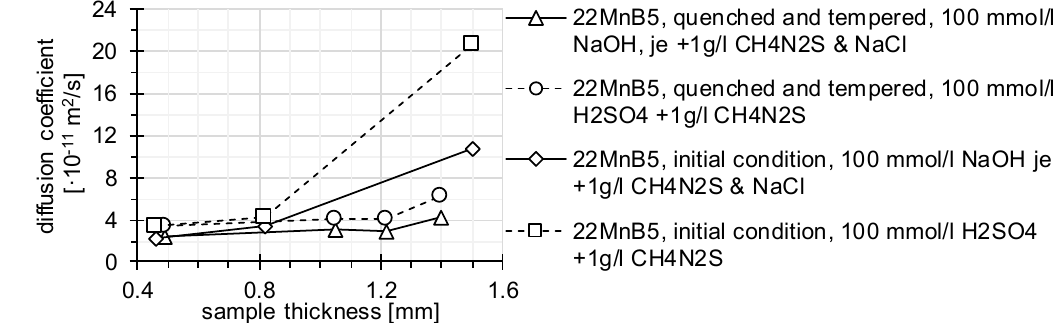
Figure 12. Impact of sample thickness on permeation measurement 22MnB5 in untempered and tempered condition.